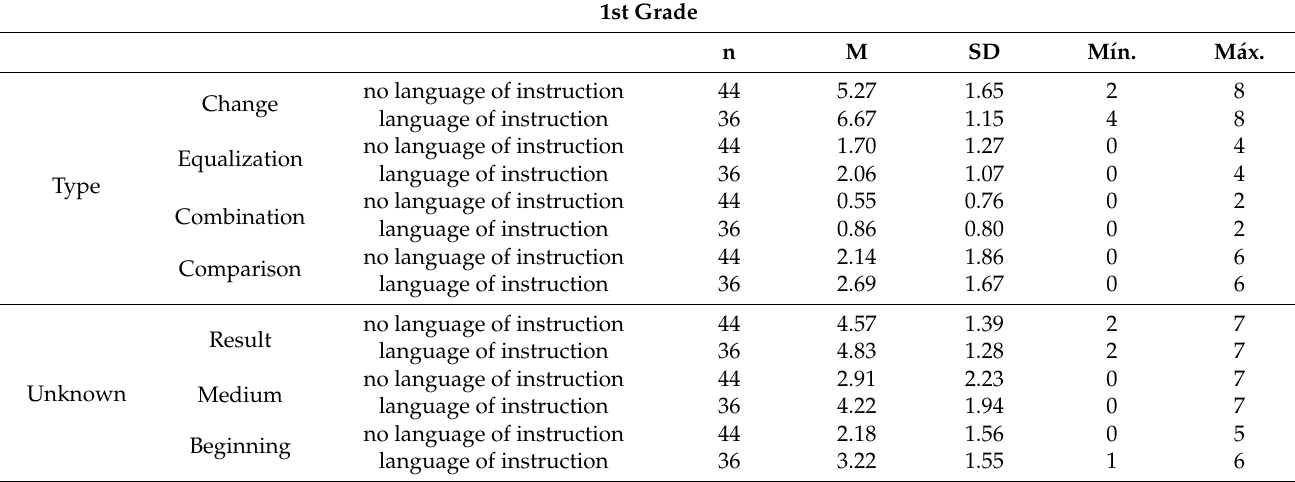
Table 6. Descriptive statistics by language coincidence (yes/no) (M: mean; SD: standard